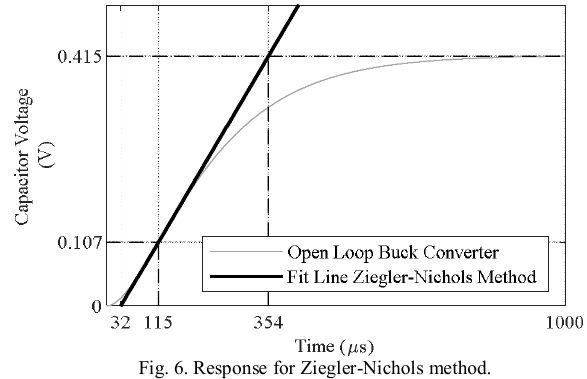
Fig. 6. Response for Ziegler-Nichols method.